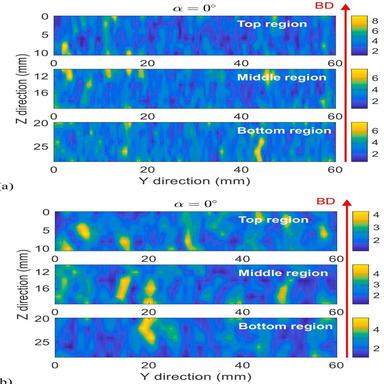
Integrated BS intensity, V, in the time gate of the data acquired for different focal planes. (a) F = 12mm, and (b) F = 25mm.